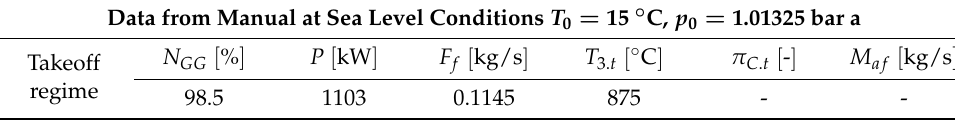
Table 4. Engine data for takeoff regime, based on the engine manual.